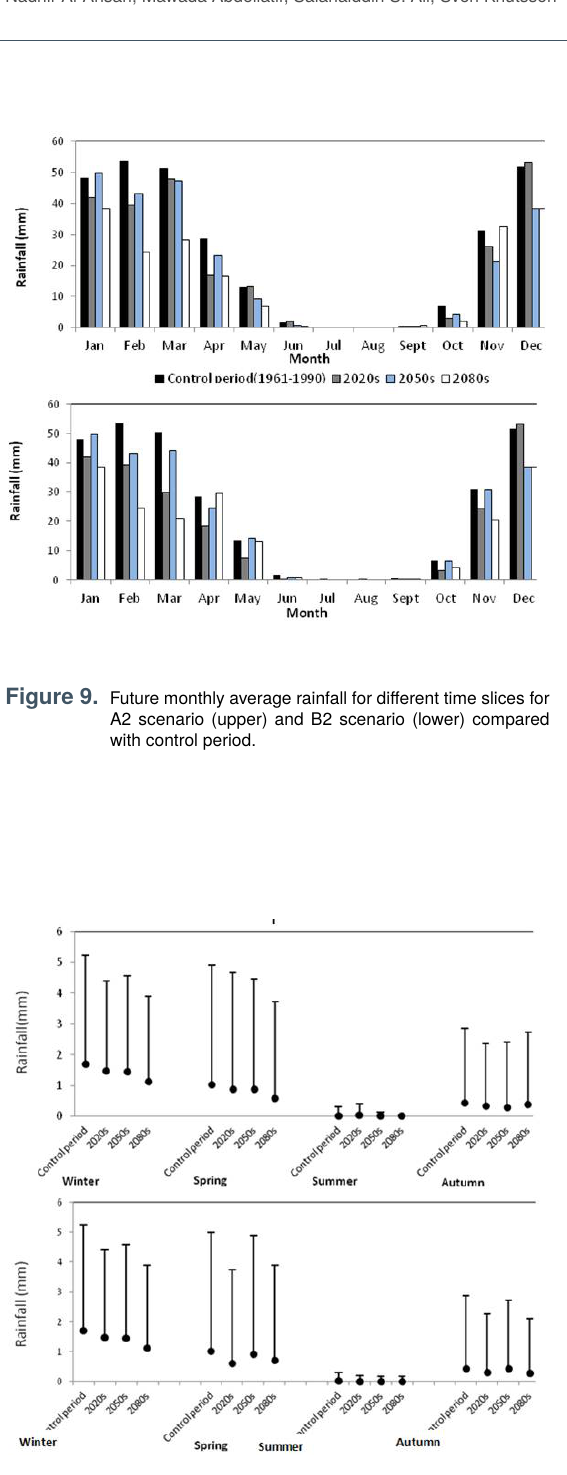
Figure 10. Seasonal average daily rainfall for different future time slices for A2 scenario (upper) and B2 scenario (lower) compared with control period. The vertical error bars indicate the standard deviation.